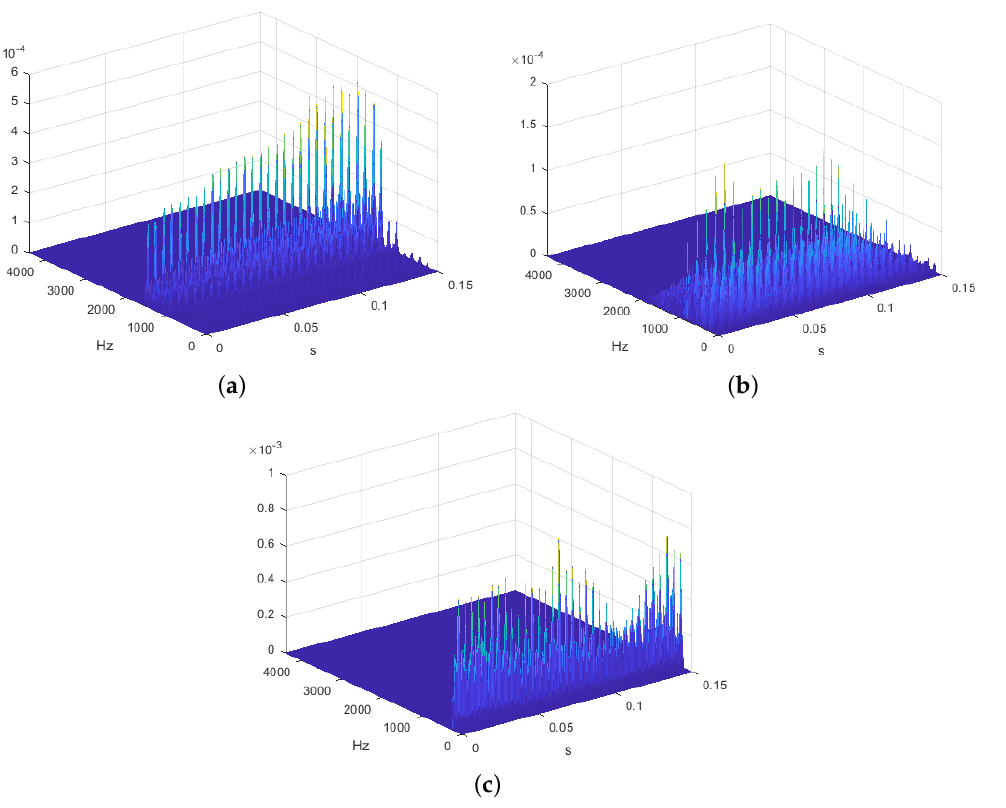
Figure 1. pD ( f , t ) of vowel “ a ” for 3 different patients with bulbar involvement. The marked difference in the graphic representation of the time-frequency between the subjects can be clearly ap- preciated. ( a ) Patient pD without bulbar involvement. ( b ) Patient pD with slight bulbar involvement. ( c ) Patient pD with severe bulbar